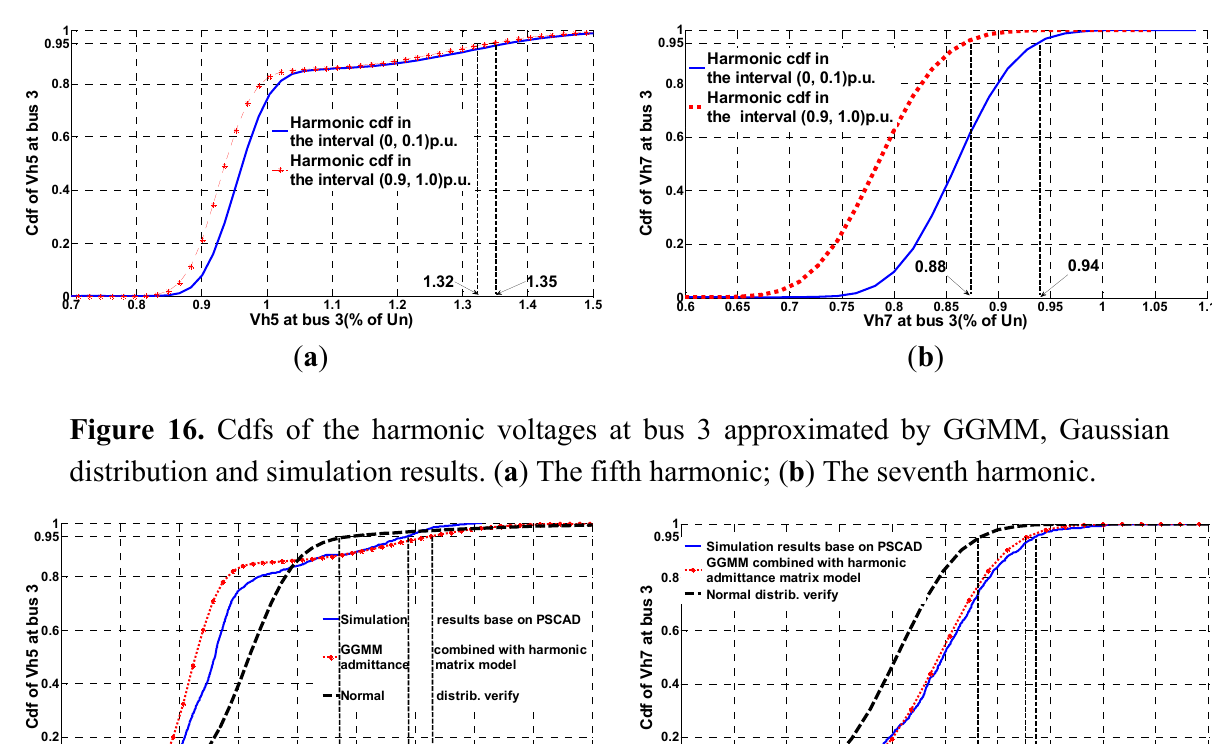
Figure 15. Cdfs of the harmonic voltages at bus 3 in different intervals. ( a ) The fifth harmonic voltage magnitude; ( b ) The seventh harmonic voltage magnitude.